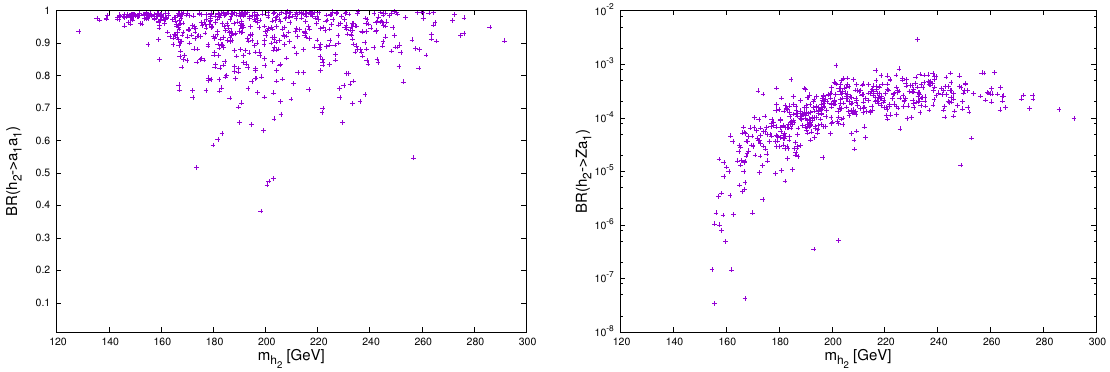
( right plot ) [58]. 1